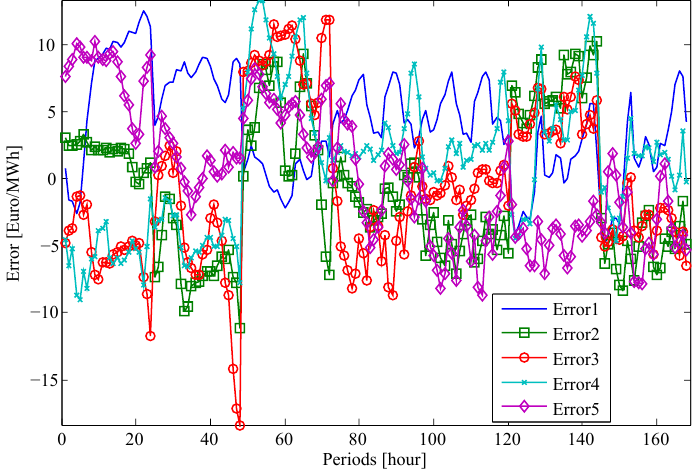
Figure 7. Input data of the forecasted